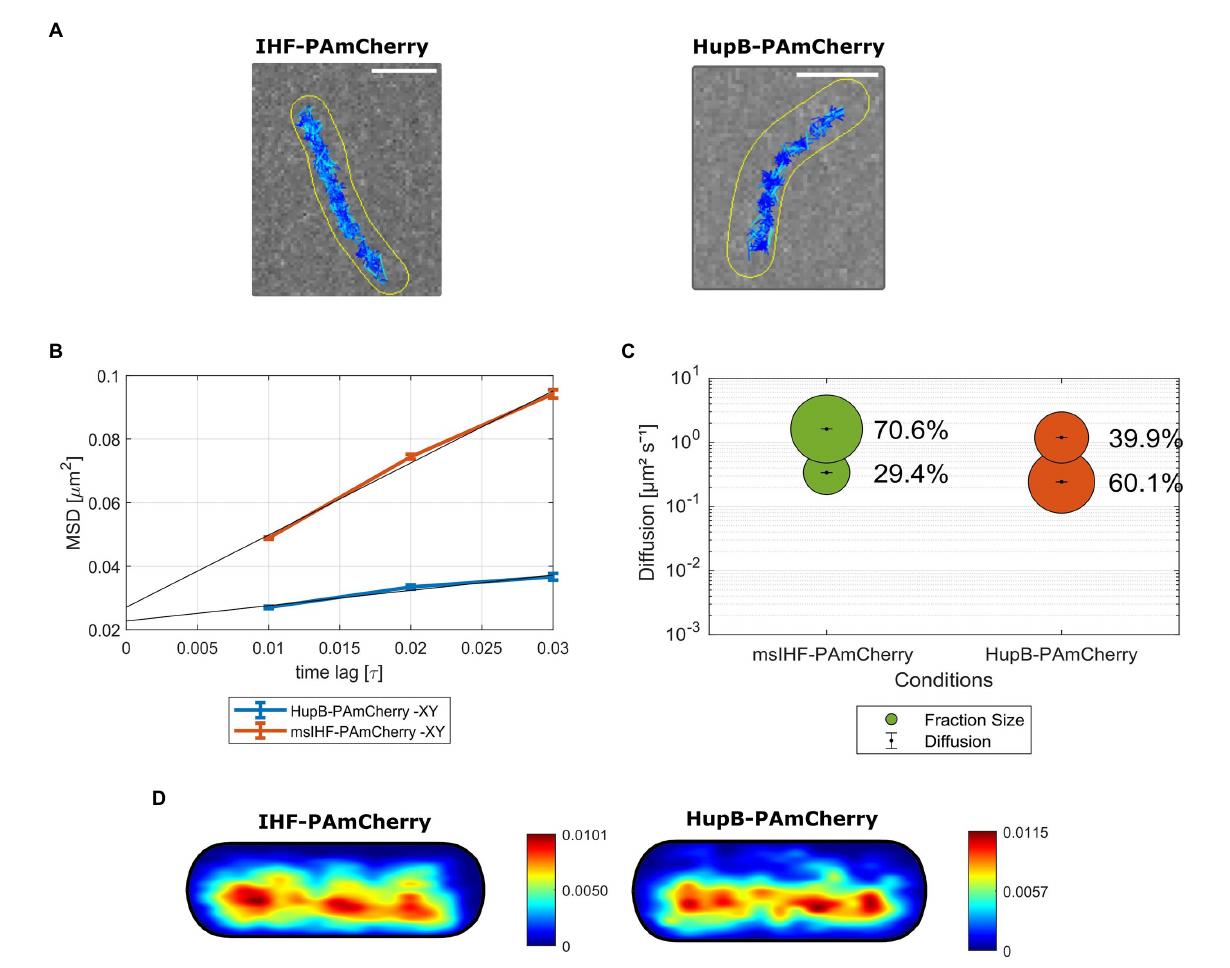
FIGURE 3 Single-particle tracking (SPT) analysis of msIHF-PAmCherry and HupB-PAmCherry particle mobility. (A) Representative cells of msIHF-PAmCherry and HupB-PAmCherry strains with identified tracks. The intensity of the dark blue color is inversely related to the length of the displacements within the presented tracks (i.e., the darkest tracks correspond to the trajectories of the most static molecules). Scale bar, 2 μ m. (B) Mean-squared displacement plotted against time lag for the analyzed fusion proteins. (C) Bubble plot presenting obtained diffusion coefficients and the subpopulations sizes for msIHF-PAmCherry and HupB-PAmCherry molecules. (D) Heat maps for the average msIHF-PAmCherry and HupB-PAmCherry cells presenting likeness of presence of confined and mobile tracks from low (blue) to high